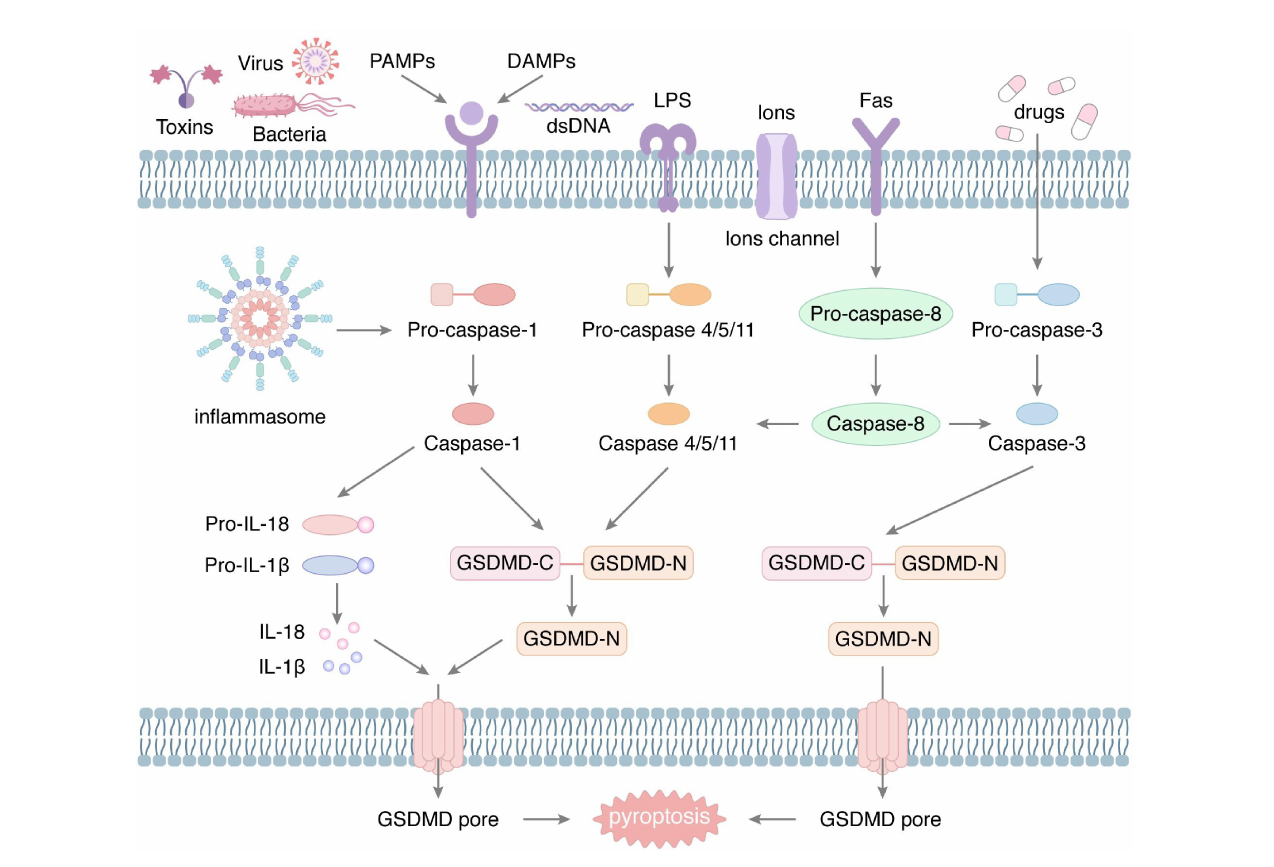
FIGURE1 The molecular mechanism of pyroptosis. The classical pyroptosis is produced under the stimulation of a variety of external factors, such as bacteria, viruses, and toxins, which can activate the inflammasome. Activated inflammasome induces cleavage of pro-caspase-1 to form